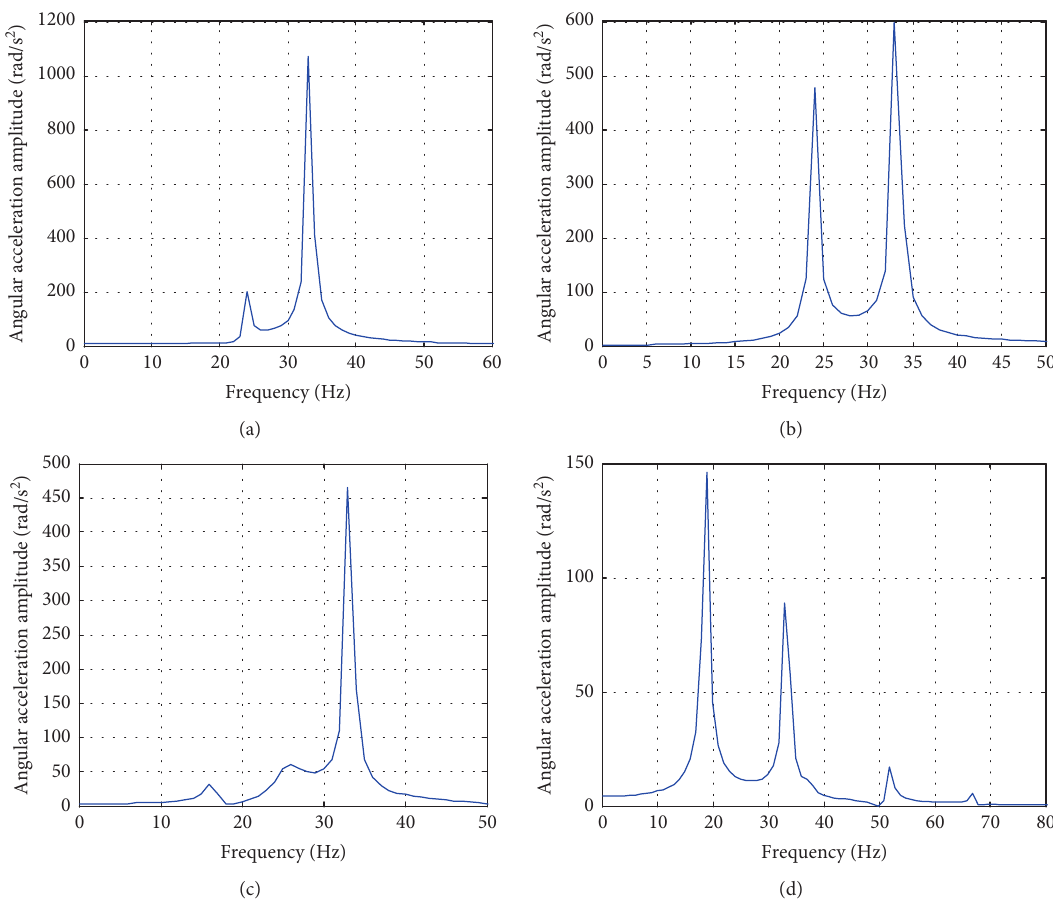
Figure 13: Spectra of J 8 and J 10 at 1000r/min of engine speed: (a) spectrum of J 8 and (b) spectrum of J 10 of DMF; (c) spectrum of J 10 of DMF with simple CPVA; (d) spectrum of J 10 of DMF with bifilar